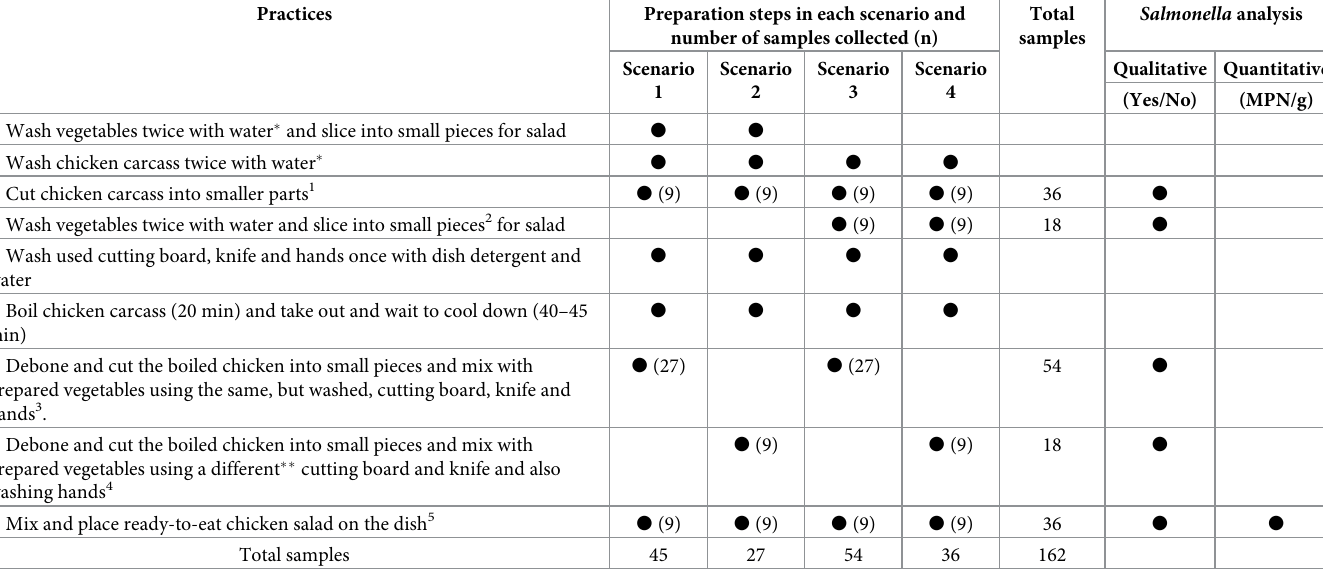
Table 1. Chicken salad preparation steps in each experimental scenario and the number of samples collected and